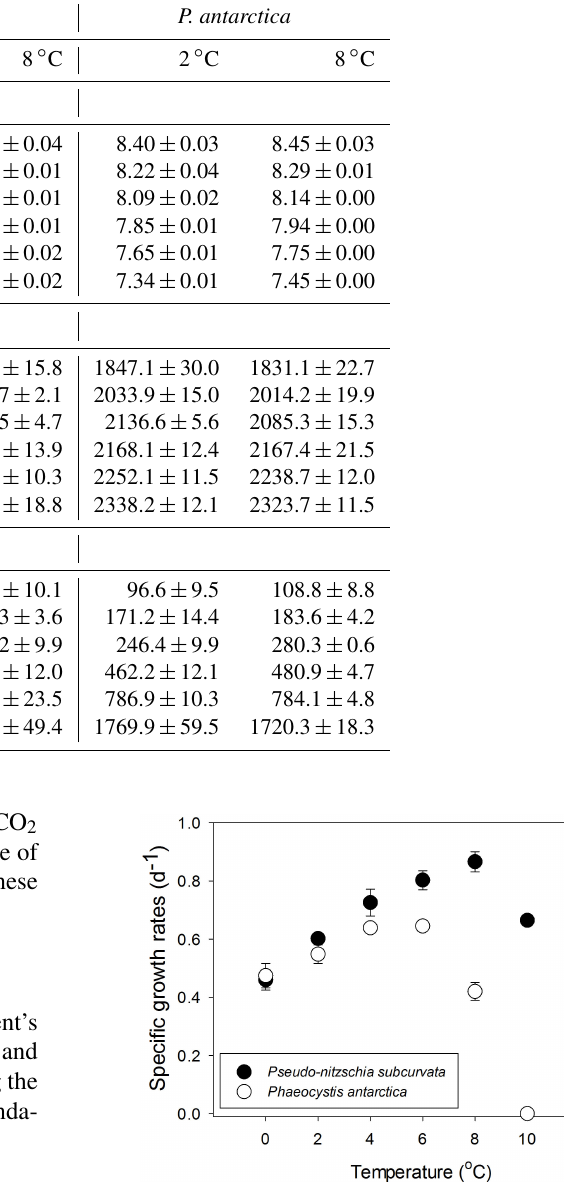
Figure 1. Thermal functional response curves showing specific growth rates of Pseudo-nitzschia subcurvata and Phaeocystis antarctica across a range of temperatures from 0 to 14 ◦ C. Values represent the means and error bars represents the standard devia- tions of triplicate samples.